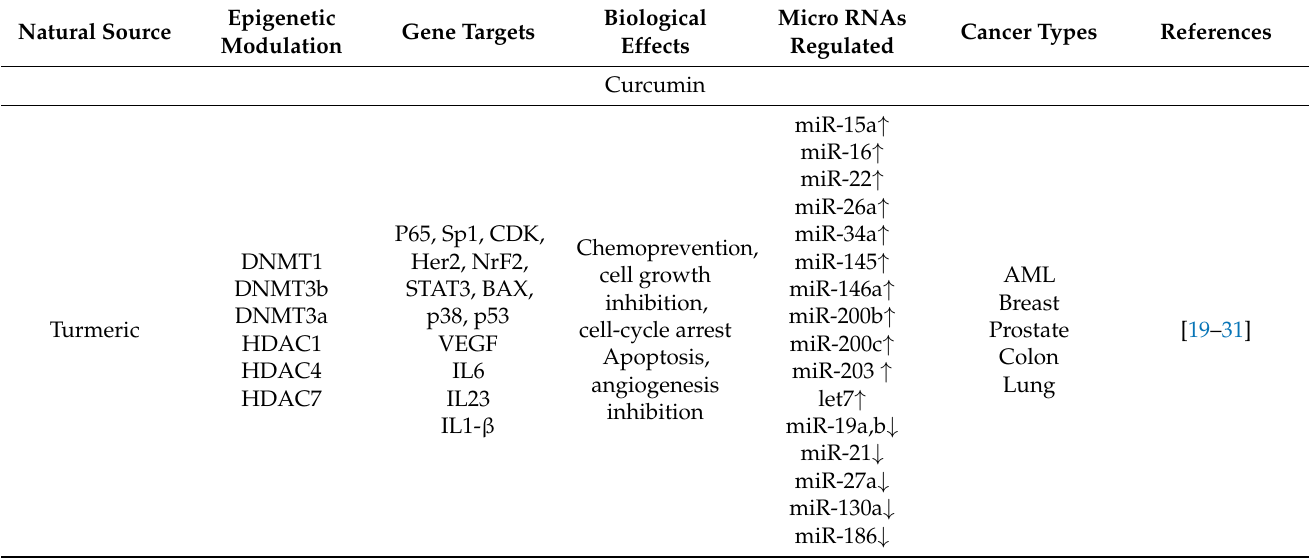
Table 1. Summary of the gene expression variability and antitumor